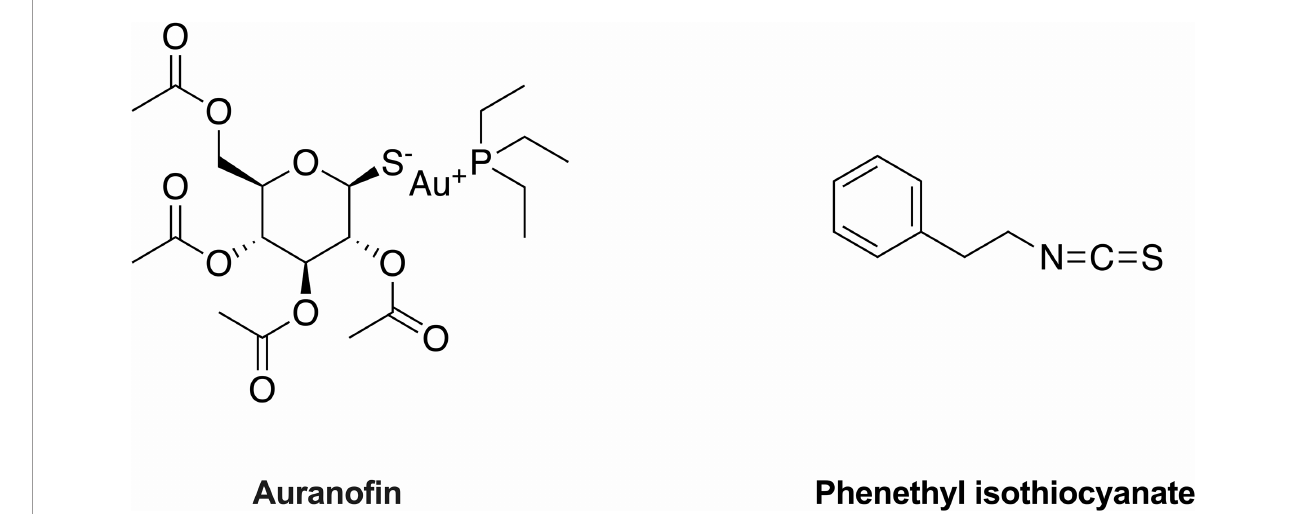
FIGURE 1 | The structure of aurano fi n and phenethyl